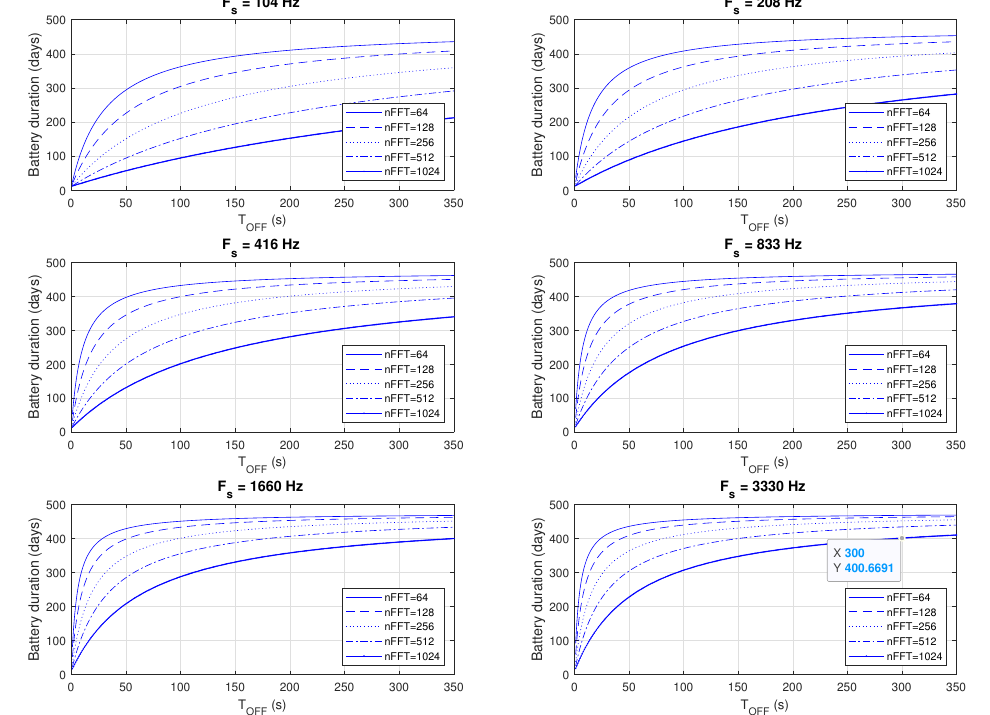
Figure 15. Battery duration for the ST controller and operating mode T OFF > 0.